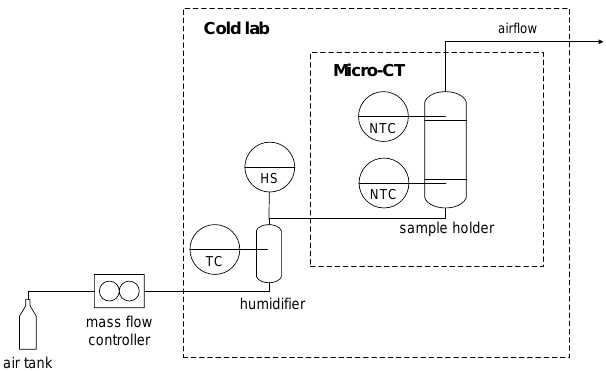
Figure 2. Schematic of the sample holder design for flow across the snow sample (left) and for flow over the snow surface (right). The dimension of the analyzed snow sample for both setups is 50mm diameter and 30mm